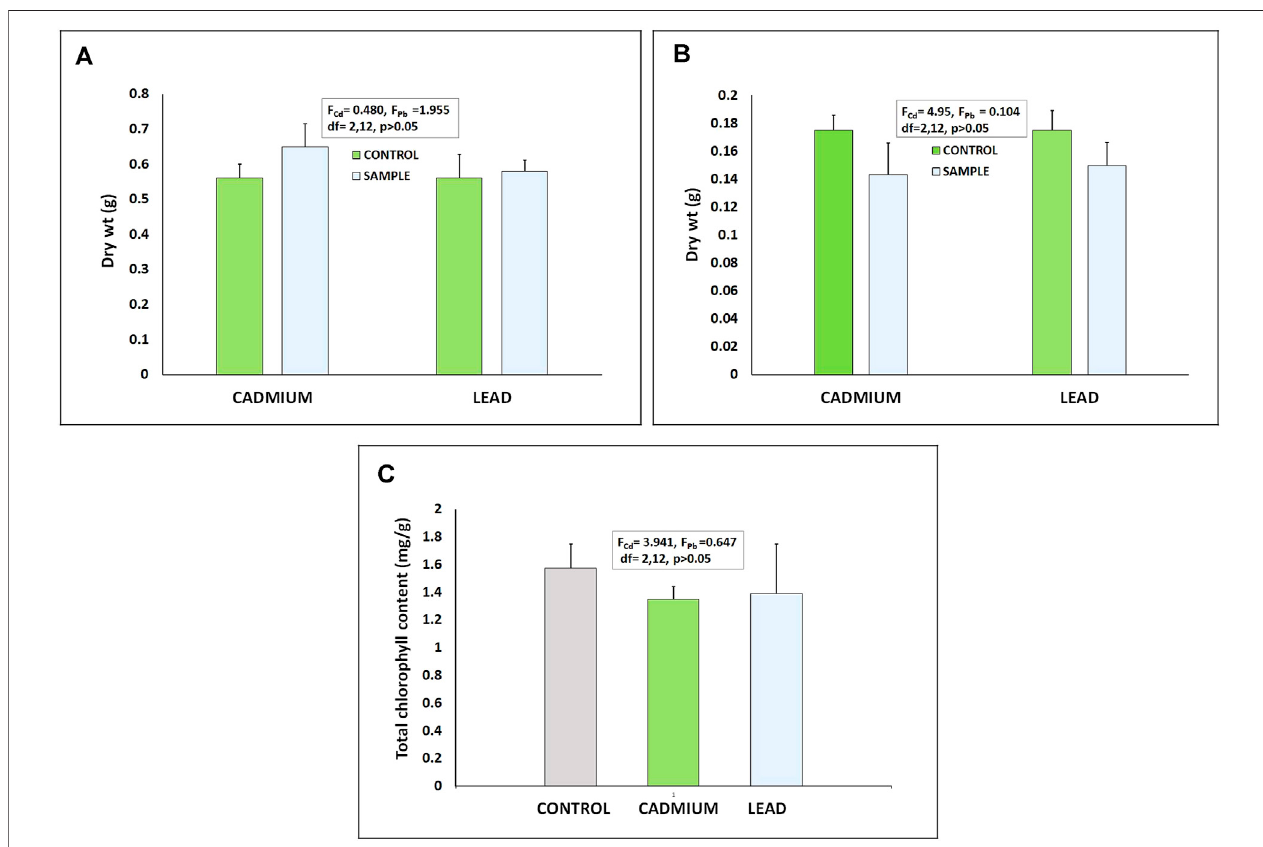
FIGURE 2 | Phytophysiological effects of heavy metal stress on Cleome rutidosperma based on hydroponic experiments: (A) and (B) biomass of shoot and root, respectively, and (C) total chlorophyll content. The results did not differ signi fi cantly w.r.t control (F values and “ degrees of freedom (df) ” are given in the respective